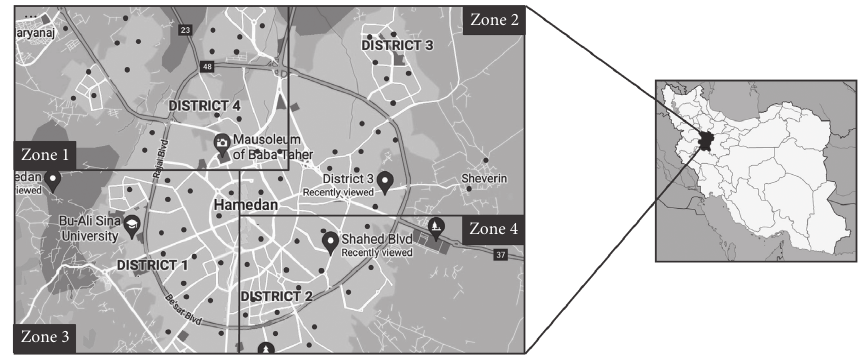
Figure 1: Geographical locations of milk sampling sites in Hamadan city, Table 1: Linearity range and quantification limits for steroid hormones analyses using the ELISA method. Steroid hormones Range